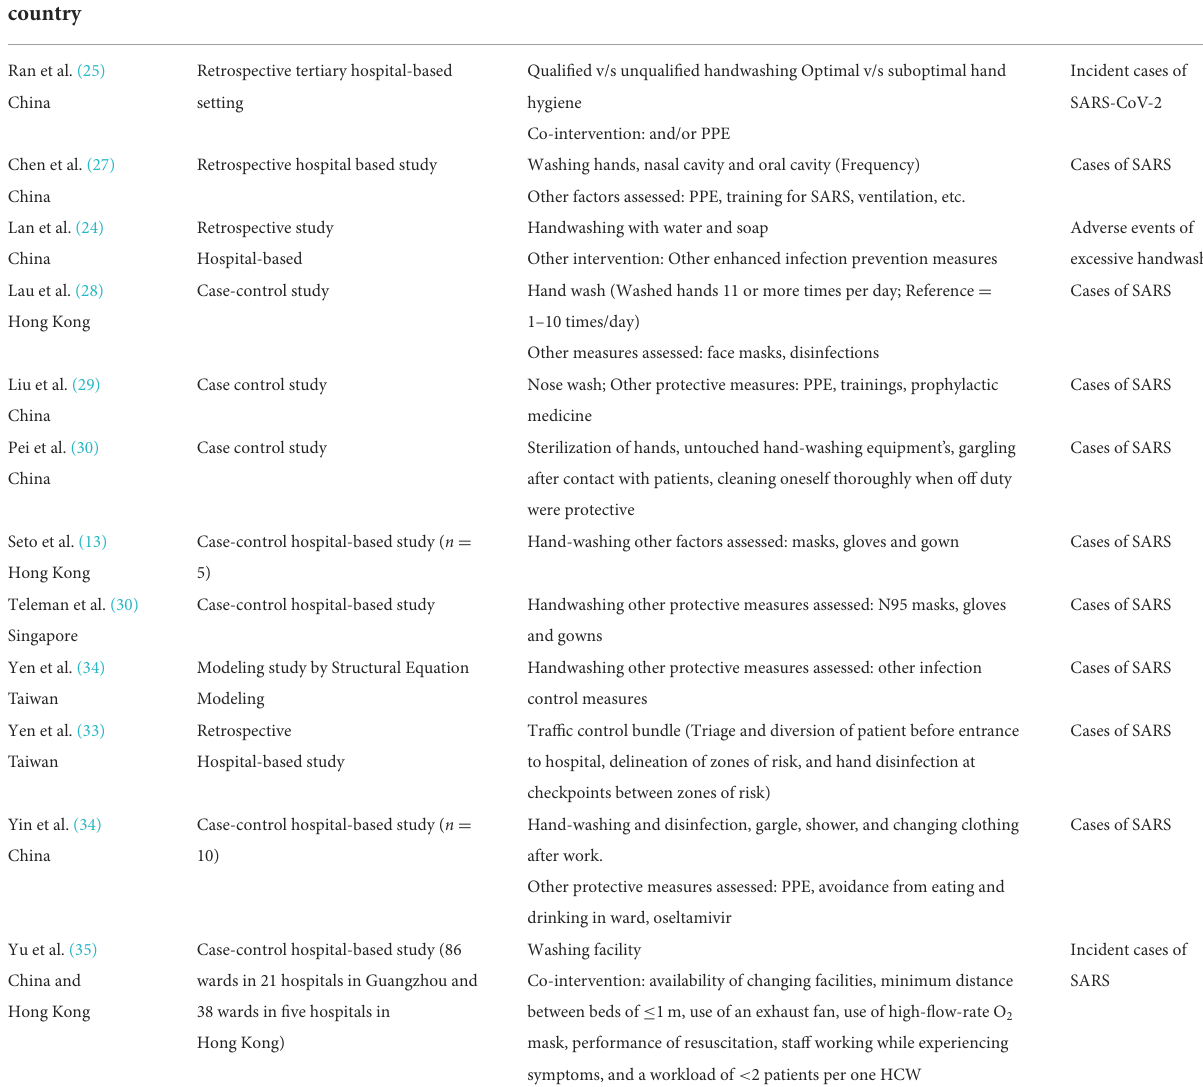
TABLE 2 Characteristics of included